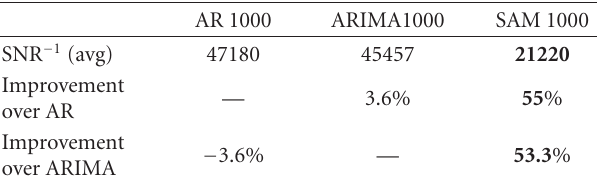
Figure 7: Comparisons between AR, ARIMA, and SAM SNR − 1 values.